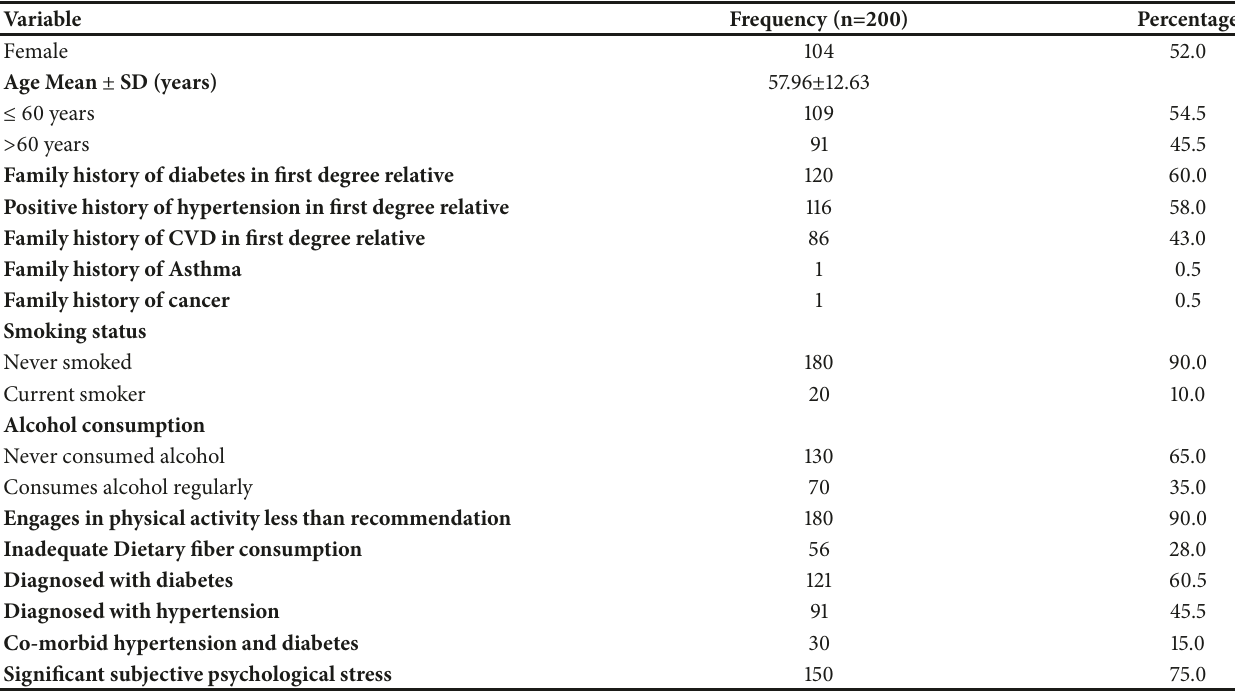
Table 1: Sociodemographic/medical history of study